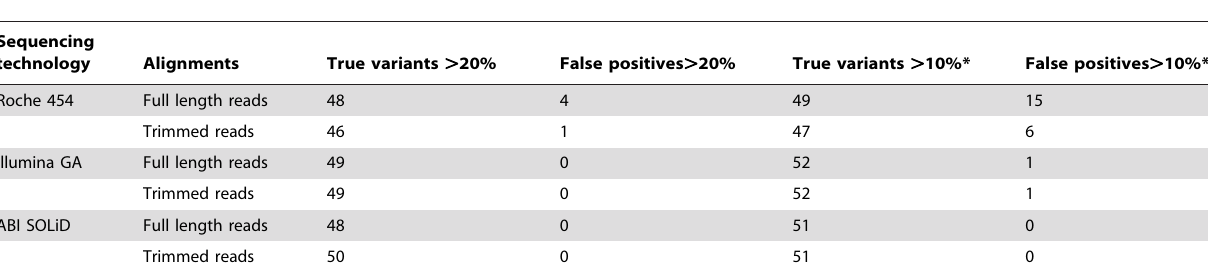
Table 3. Number of SNPs and false positive variants detected, after alignments of untrimmed reads.